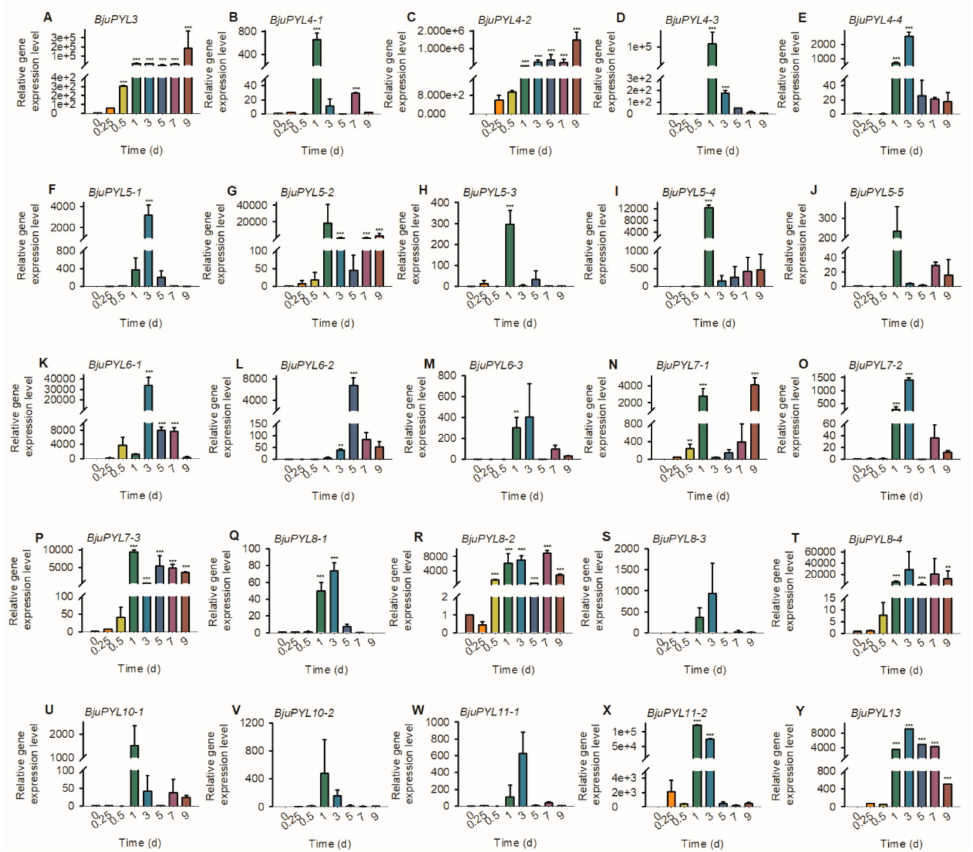
Figure 7. The expression patterns of BjuPYLs under pathogen treatment. Total RNA was extracted from 2-week-old seedlings treated with P. brassicae for the indicated time points. Data were normalized to the expression level of BjuActin3 . The values are means ± standard error. Three independent biological repeats were